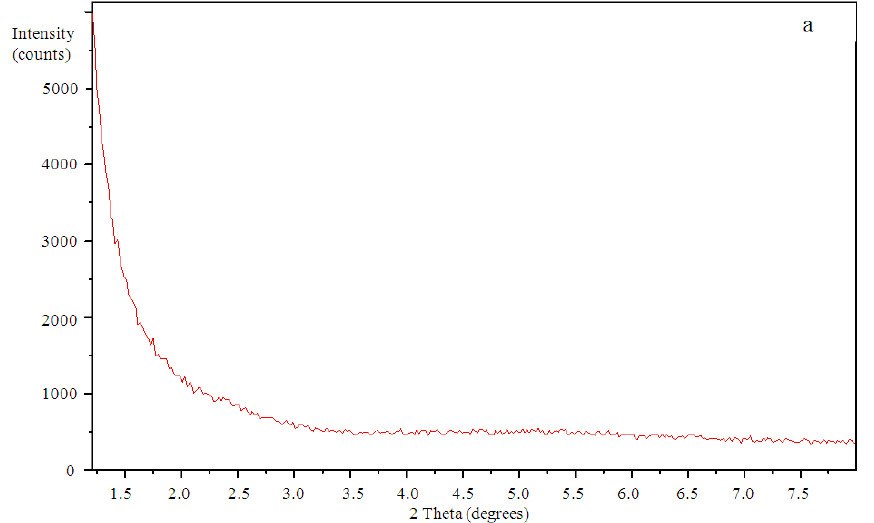
Figure 9. The SAXS diffraction pattern for the DGEBA-Lupasol nanocomposite with three different clay contents: ( a ) 2 wt%; ( b ) 5 wt%; ( c ) 10